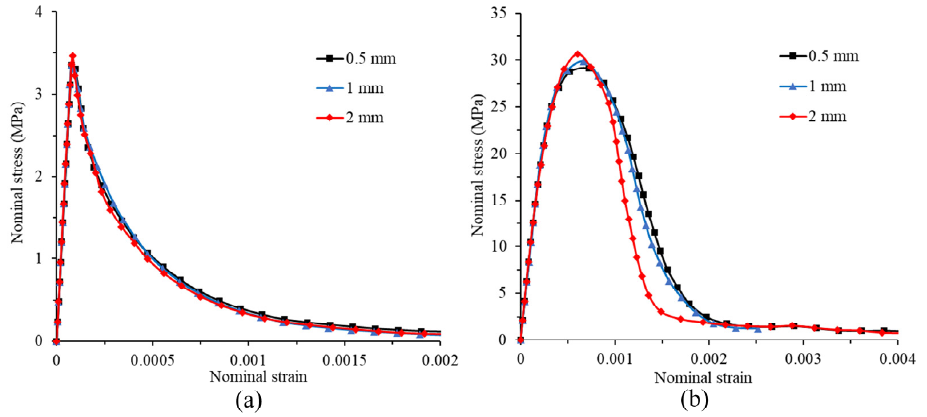
. ε  ε = 100 s − 1 100 s − 1 .